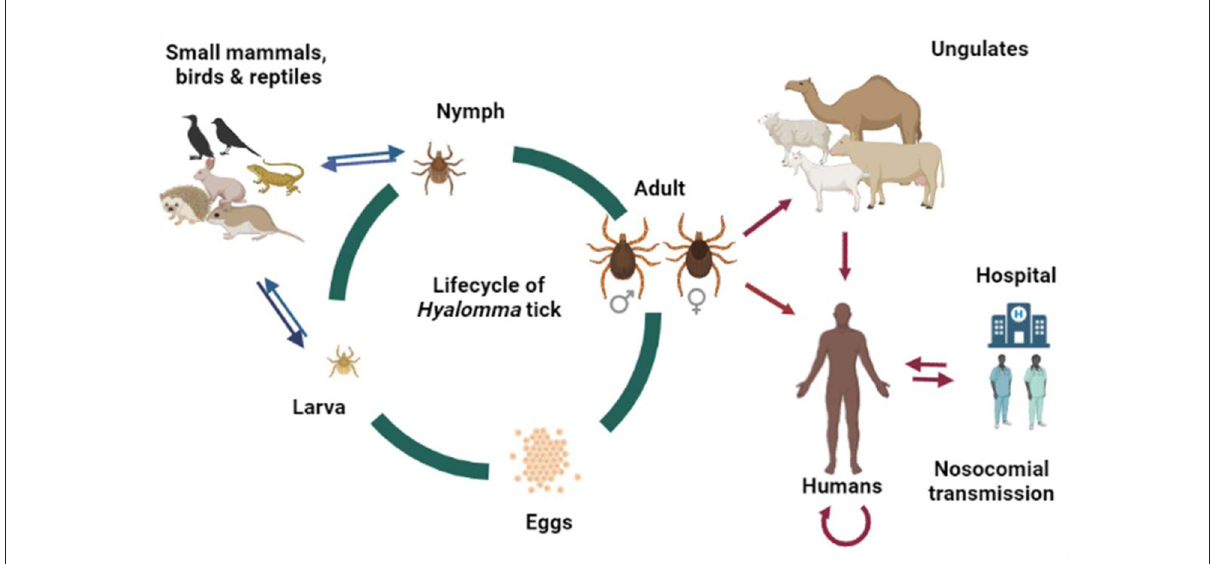
FIGURE5 Lifecycle of Hyalomma tick and potential transmission route of CCHFV in the Arab world. The original figure was created with BioRender